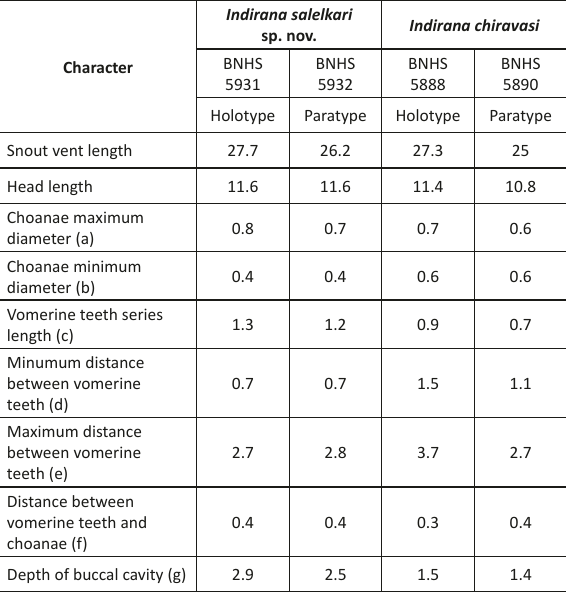
Table 2. Factor loadings for variables along the first three axes of Discriminant Analysis.